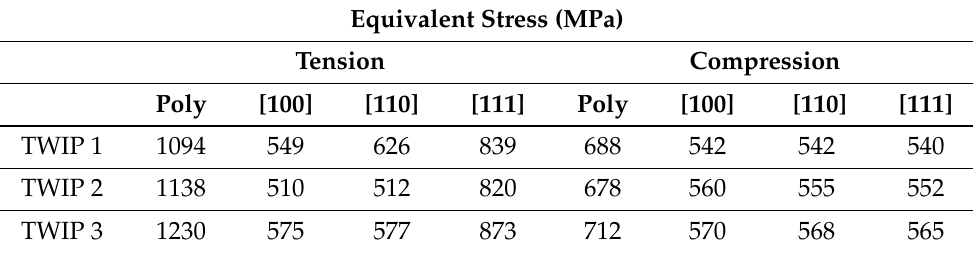
Figure 9. Deformation behavior of single-crystal and polycrystal TWIP steels subjected to compression. Table 4. Comparison of equivalent stress at 0.4 equivalent strain of single-crystal and polycrystal TWIP steels under tension and